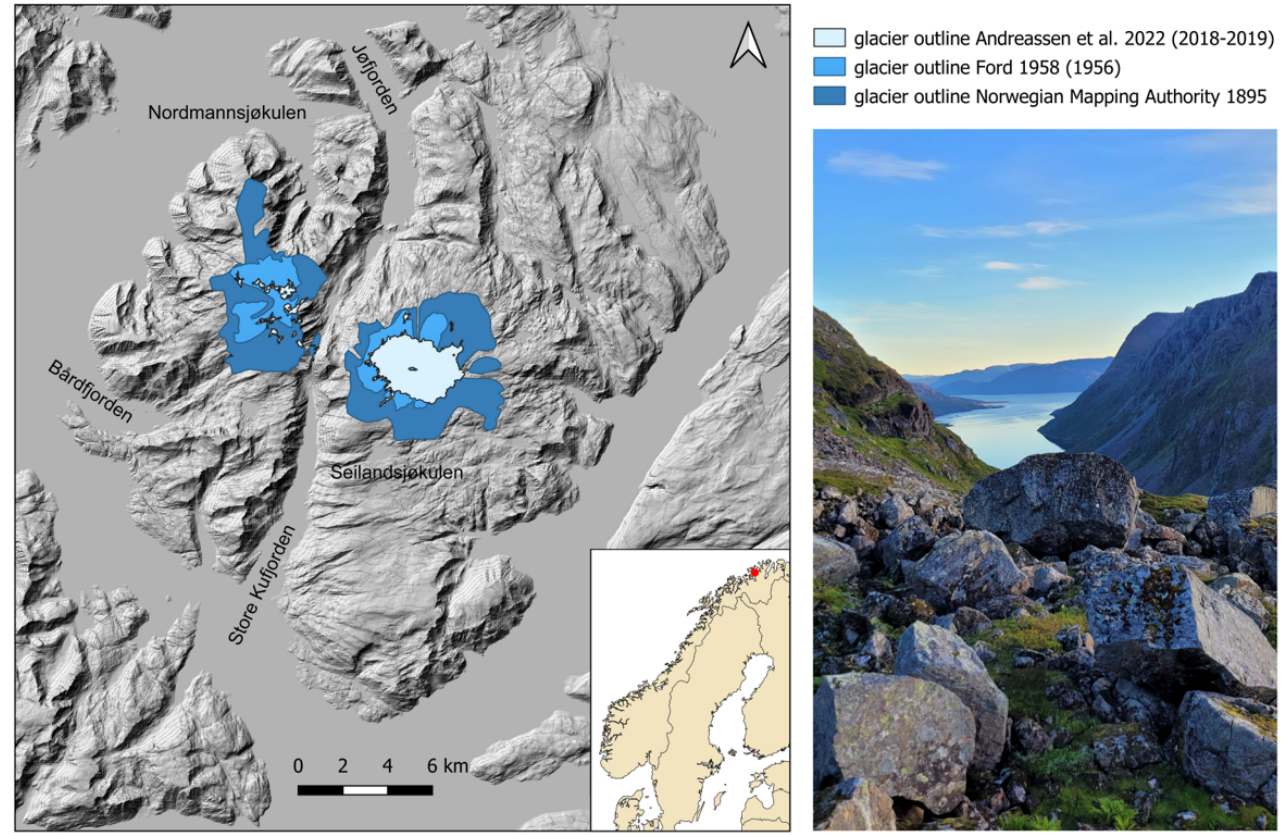
Figure 1. The island of Seiland in northern Norway (red dot) with remnants of glaciers on the high plateau. The earliest documentation of the glaciers stems from a map created by the Norwegian Mapping Authority in 1895. The glaciers’ extents were documented anew in 1956 [20] and then again in 2018–2019 [21]. In many parts of the island, access to the plateau is restricted through steep slopes and large boulders. The image was taken standing on the eastern half of the island south of the glacier looking down Store Kufjorden (Photograph: G. Caspari). WGS 84/UTM Zone 34N.